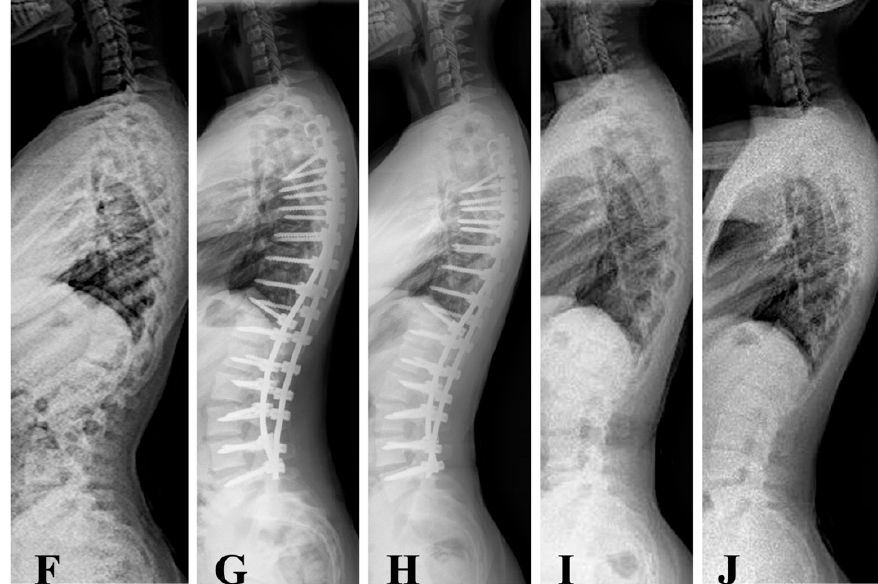
Figure 3. A 14-year-and-11-month-old girl with Lenke type 5 AIS (17/36/57), with T10-L2 kyphosis (+16°) and Risser 3 ( A , F ). Posterior pedicle instrumentation T4-L5 ( B , G ) was performed, achieving correction of the thoracolumbar and thoracic curve ( B ). In the sagittal plane, the correction of the thoracolumbar transit kyphosis ( G ) was also verified. The coronal and sagittal angular values remained unchanged until the removal of the vertebral instrumentation ( C , H ) and in the radiographic study after the removal of the implants ( D , I ). In the last radiographic control, two years after the removal of the instrumentation, the thoracic scoliosis ( E ) and the sagittal vertebral angular values remained unchanged ( J ). Table 1. Clinical pro fi le and characteristics of the curves.